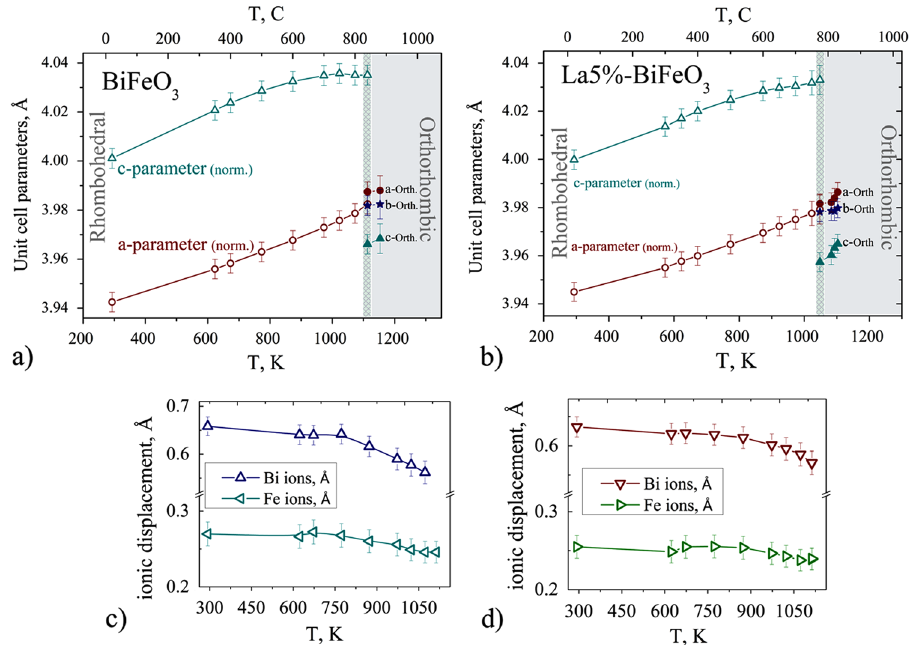
Fig. 1 Temperature evolution of the unit cell parameters and ionic displacements calculated for the pristine ( a , c ) and La-doped ( b , d ) BiFeO 3 compounds based on the NPD data. The rhombohedralorthorhombic transition and temperature region attributed to the orthorhombic phase are highlighted by gray vertical